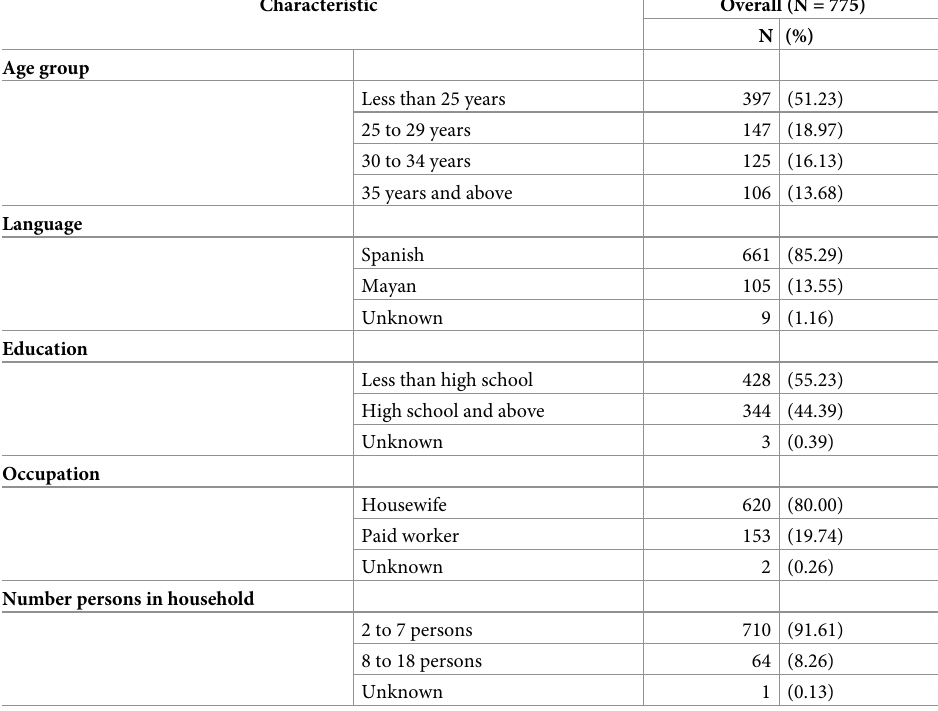
Table 1. Sociodemographic characteristics of study